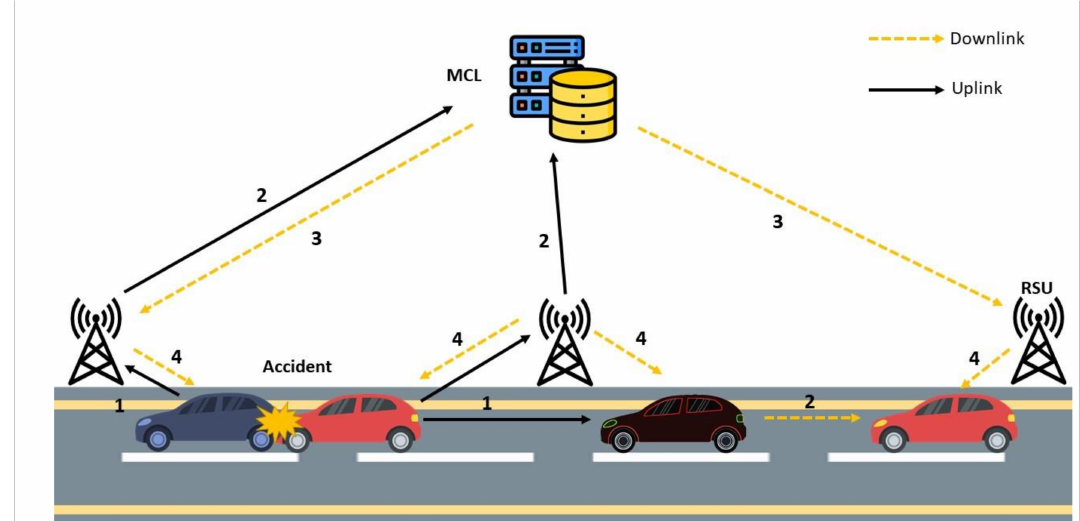
Figure 4. A communication scenario in the sensing and reporting layer.